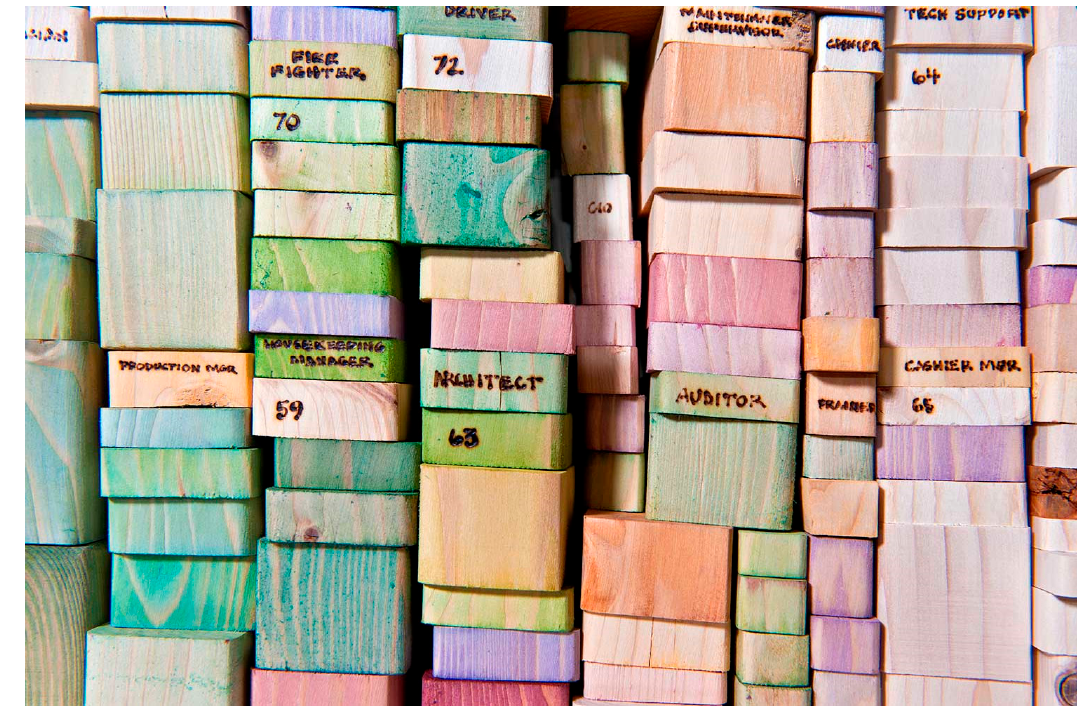
Figure 6. Seven Stages of ALS. Courtesy of the author.